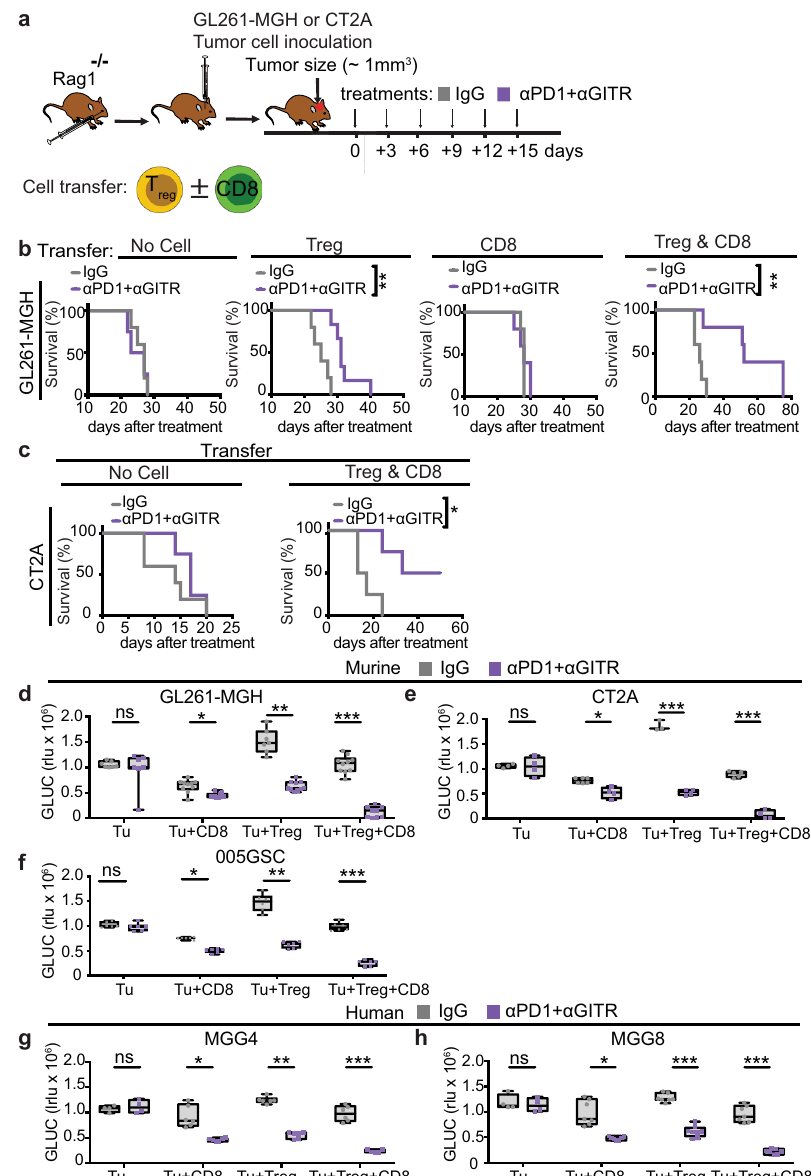
Fig. 4 CD4 Treg cells are suf fi cient to elicit the therapeutic effect of α PD1 + α GITR and induce tumor cell killing. a Schematic representation of the experimental setup to evaluate the contributions of CD8 T cells and Treg cells to antitumor activity against GBM during α PD1 + α GITR treatment. Puri fi